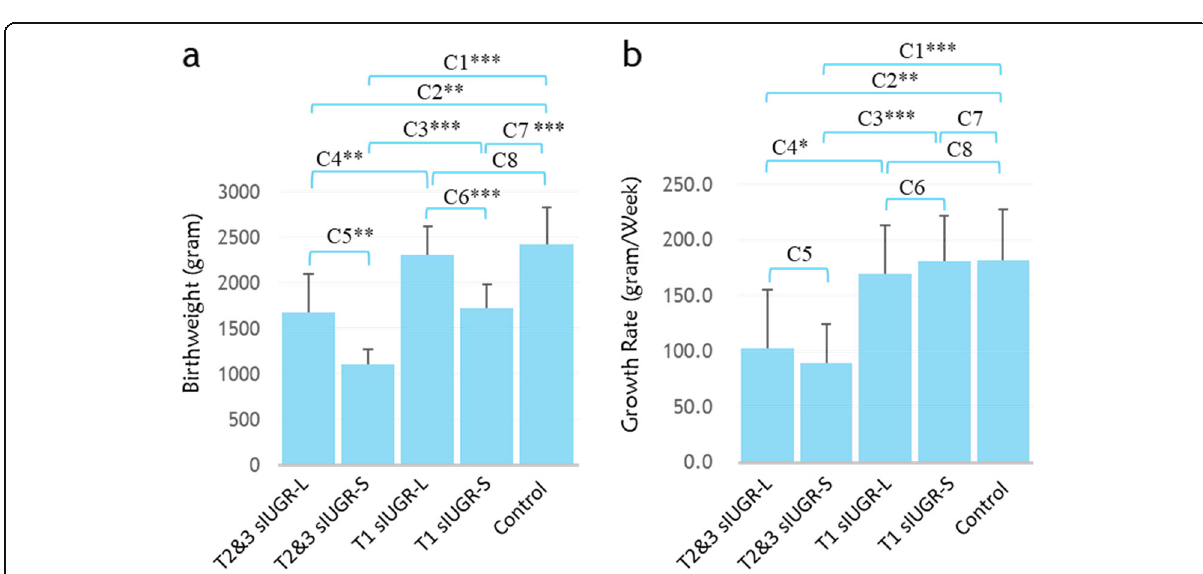
Fig. 3 Bar graphs show the birthweight ( a ) and growth rate ( b ) of all MCDA twins. The growth rate was measured every two weeks by ultrasound after 28 gestational weeks. Statistical significance between eight comparisons (C1-C8) were determined using Student ’ s t-test (* p < 0.05; ** p < 0.01; *** p < 0.001). List of abbreviations: MCDA = Monochorionic diamniotic; sIUGR = Selective intrauterine growth restriction; T1 = Normal umbilical artery flow; T2&3 = Abnormal umbilical artery flow; L = Larger twin; S = Smaller twin